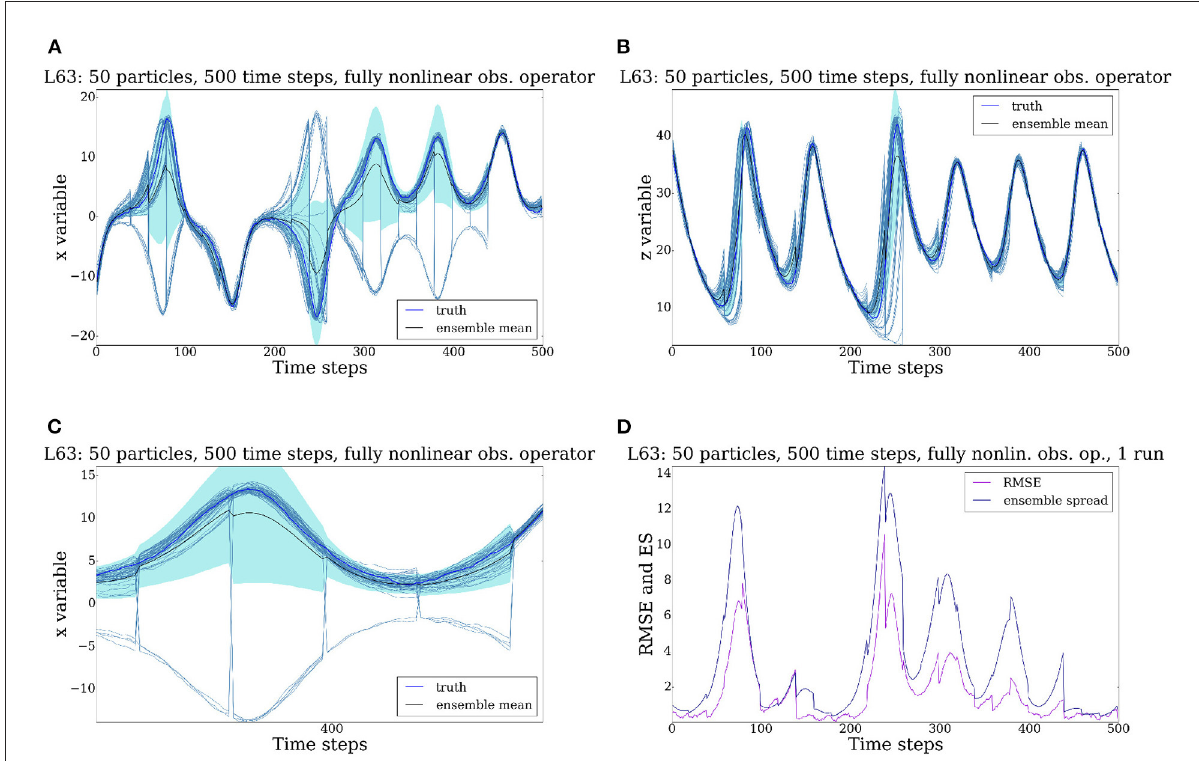
FIGURE7 Evolution of the Lorenz ’63 model for 500 time steps, all 3 variables are observed every 20 time steps. Observations are denoted by z 1 , z 2 , z 3 . Fully nonlinear observation operator i.e., z